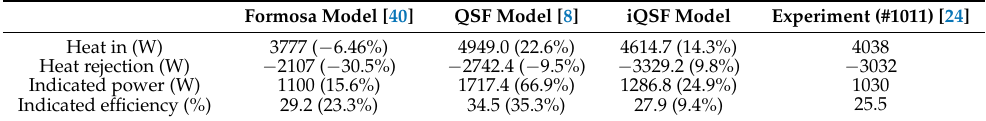
Table 10. Comparison of various model